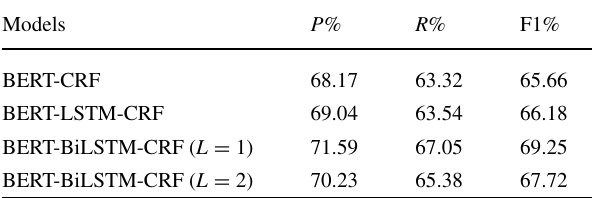
Table 4 Contributionofpre-trainedwordvectorstomodelperformance